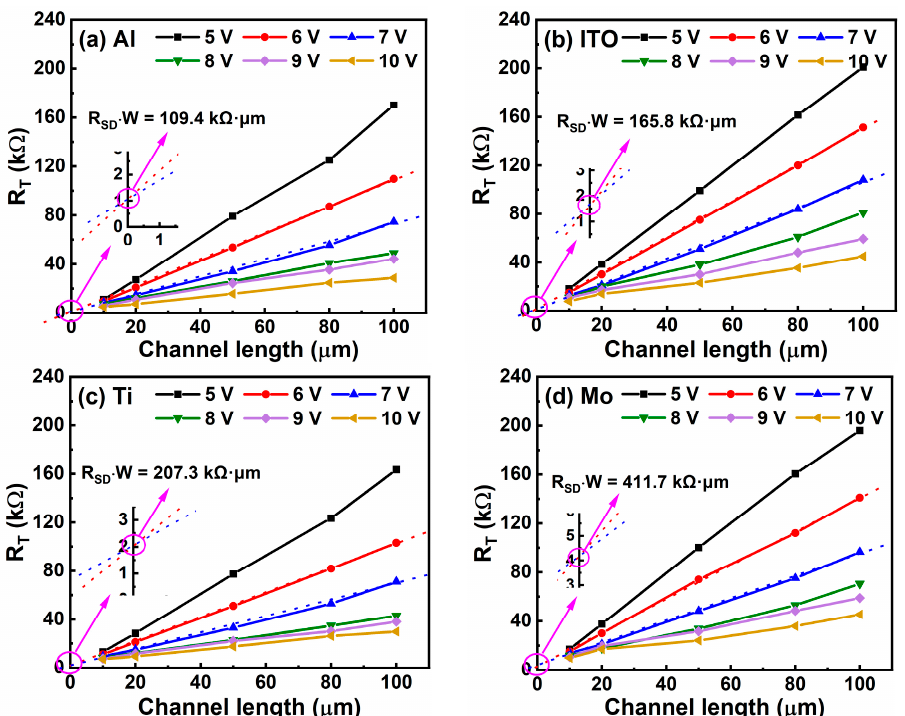
Figure 5. R T of ITO TFTs with ( a ) Al, ( b ) ITO, ( c ) Ti, and ( d ) Mo source/drain electrodes as a function of channel length with different V G . The insets show intercepts by zooming in on R T